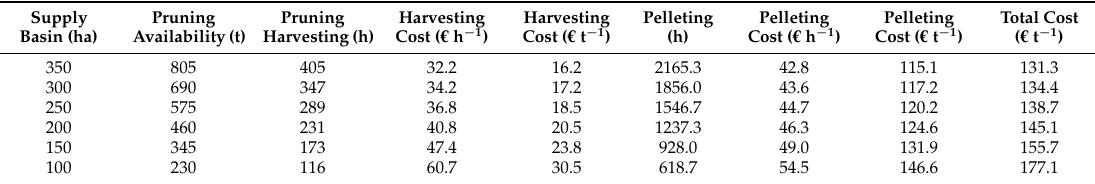
Table 10. Pruning harvesting and pelleting costs according to annual hours of machineries usage and supply basin needed (Scenario A).